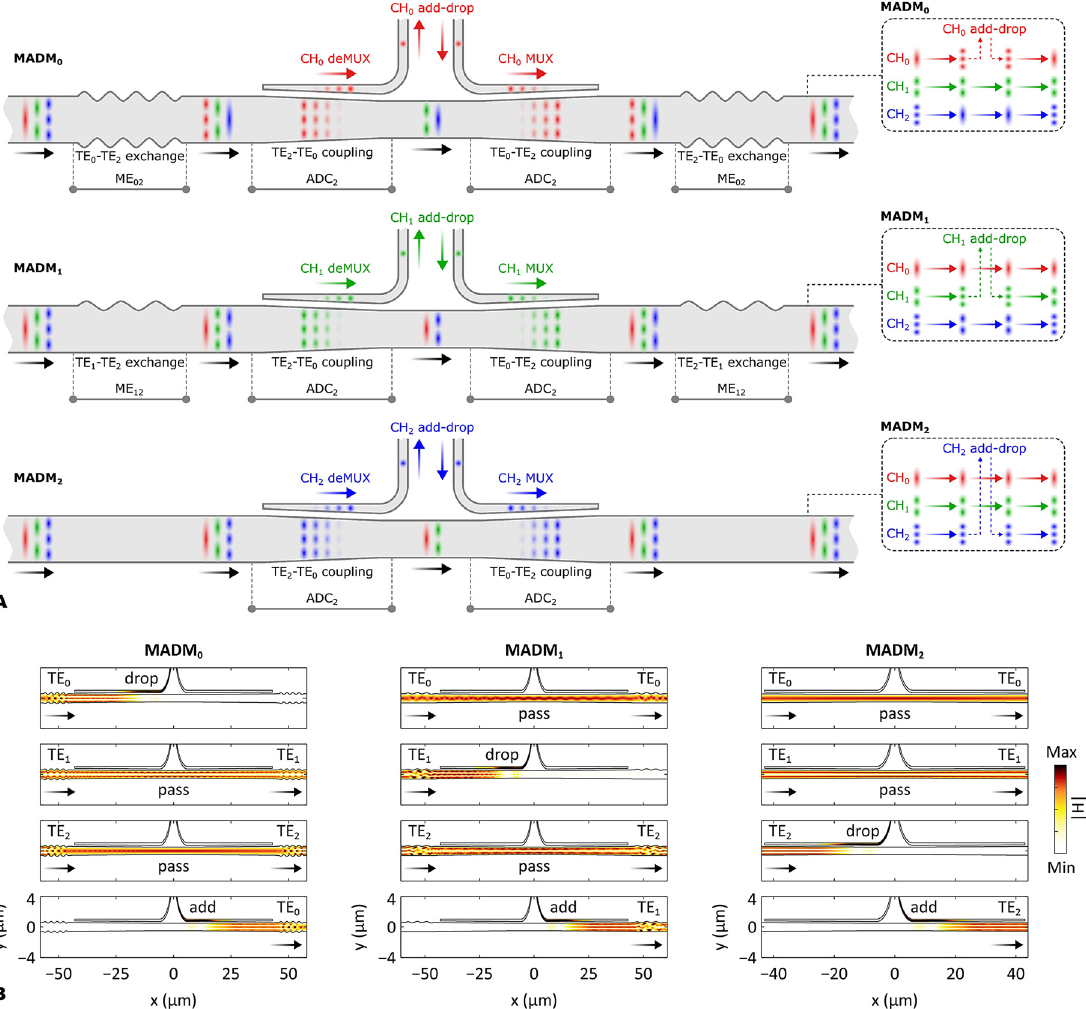
Figure 3: Design and simulation results for direct-access mode add-drop multiplexers (MADM). (A) The schematic configuration of mode add-drop multiplexers (MADM 0 – 2 ) for TE 0 – 2 modes add-drop. The insets show mode add-drop processes. (B) The calculated light propagation pro fi les for MADM 0 (left column), MADM 1 (middle column) and MADM 2 (right column) as TE 0 – 2 modes are launched. ME, mode exchanger; ADC, asymmetric directional